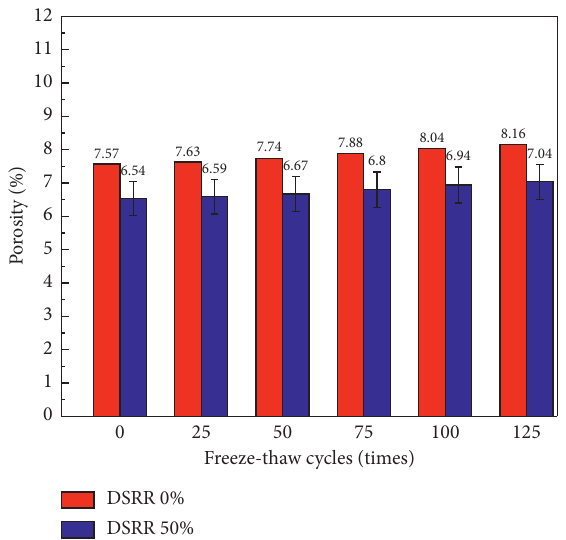
Figure 20: Porosity of OC and DSC with 50% DSRR under different freeze-thaw